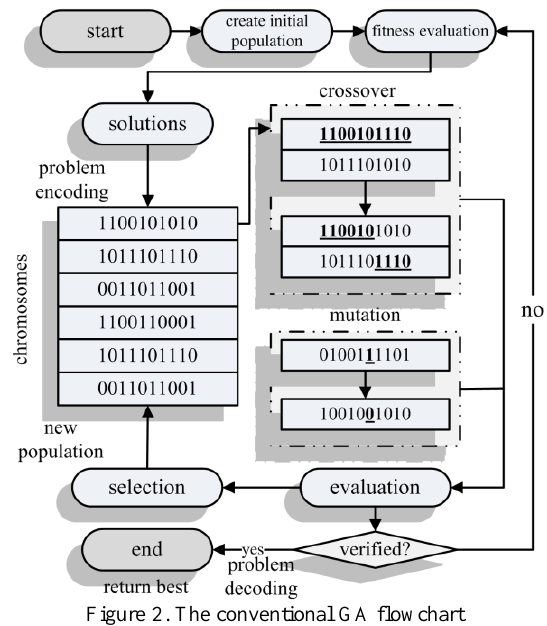
Figure 2. The conventional GA